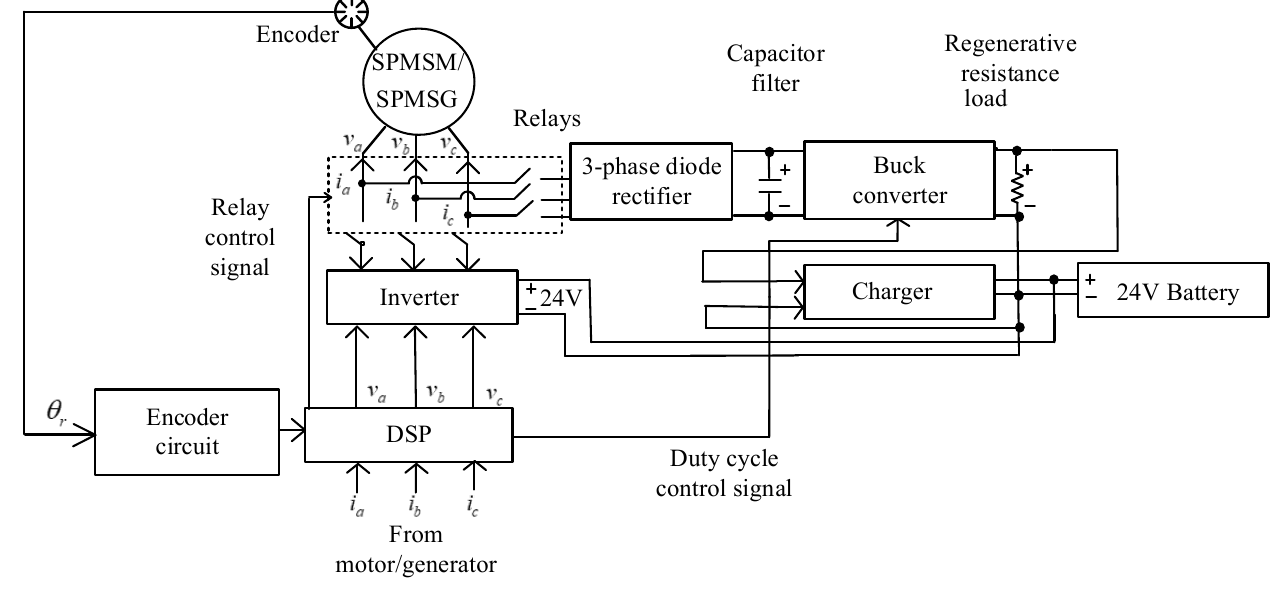
Figure 2. Block diagram of the proposed drive system.